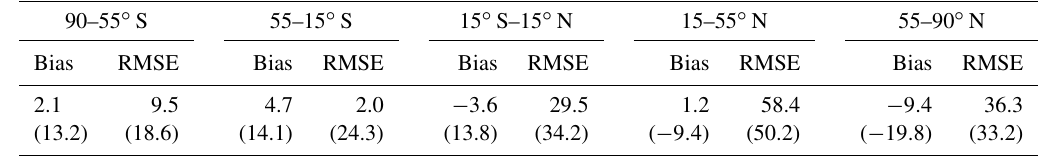
Table 5. Same as Table 2 but for surface CO concentrations. The unit is ppb. Observations used are the WDCGG observations during 2005–2014.